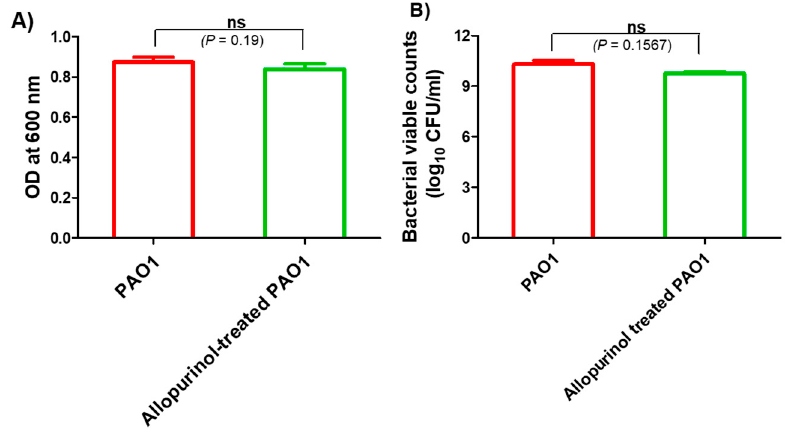
Figure 1. Allopurinol effect on P. aeruginosa PAO1 growth: ( A ) the turbidities of overnight bacterial cultures in the absence or presence of 1/10 MIC of allopurinol were measured at OD 600 nm; ( B ) viable counting of allopurinol-treated and control PAO1 cultures after overnight incubation. Allopurinol showed no statistically significant inhibitory effect on bacterial growth.